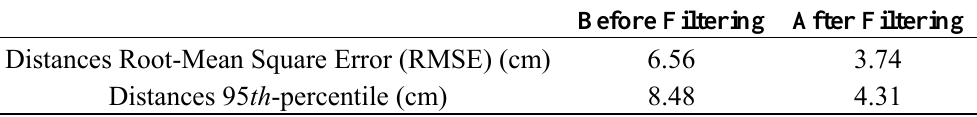
Table 1. Statistical parameters of the distribution of errors, before and after applying the proposed Kalman filter, along the 18 simulated straight paths (Figure